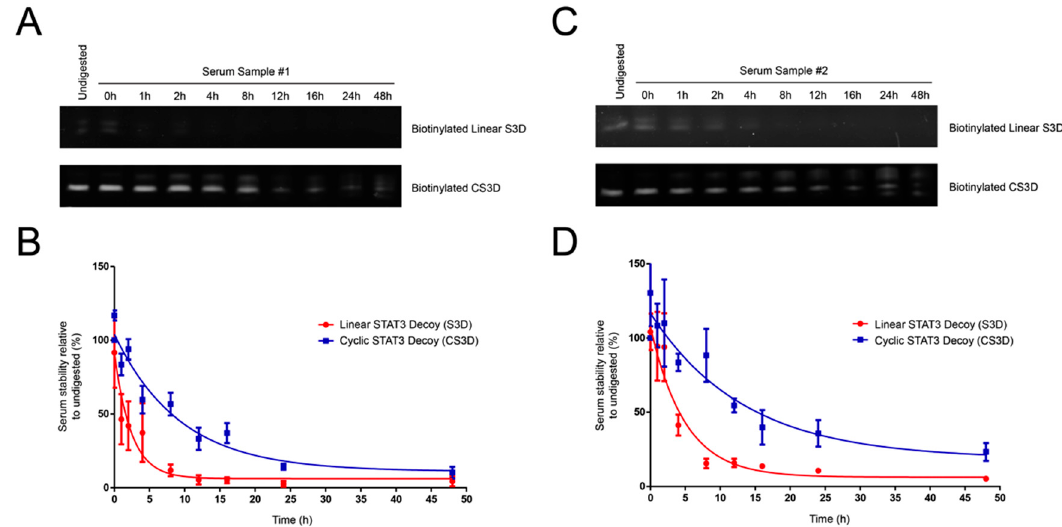
Figure 4. Cyclic signal transducer and activator of transcription 3 (STAT3) decoy (CS3D) exhibits a longer half-life in human serum than linear STAT3 decoy (S3D). ( A , C ) Biotinylated S3D and CS3D were incubated in human serum samples #1 or #2 and aliquots were removed at varying time intervals, electrophoresed on urea/polyacrylamide gels, and stained with SYBR Gold. ( B , D ) Densitometric analyses were performed on biotinylated S3D and CS3D pulled down from serum. Stability at each time point was expressed as a percent relative to its respective “undigested” control. Undigested control represents decoy suspended in 1X phosphate-buffered saline (PBS) and lacking any serum. Each time point of the S3D and CS3D serum stability assays was performed in triplicate for each sample of human serum.